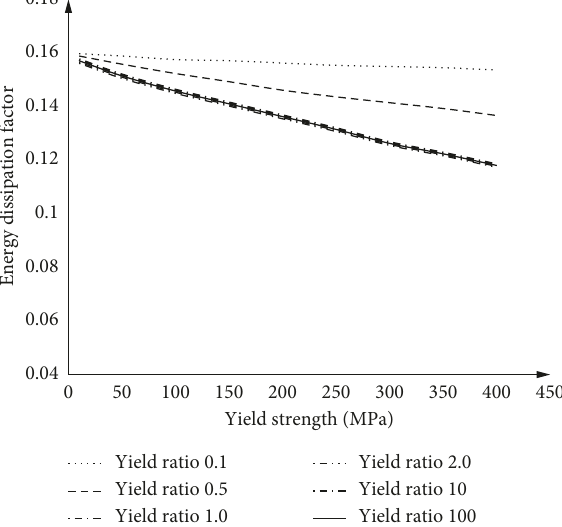
Figure 12: Curve of the energy dissipation factor under different dynamic coefficients of